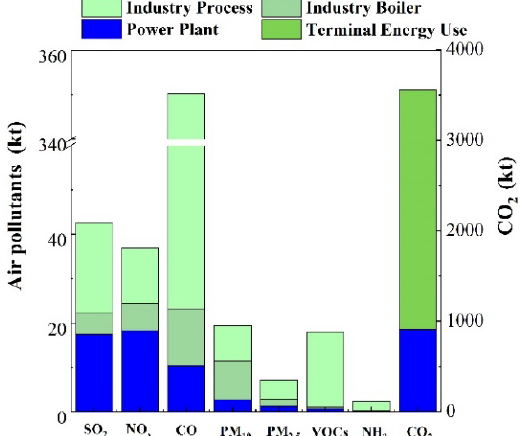
Figure 3. Emissions of air pollutants and CO 2 in industrial parks and sector contribution rates in 2017 (Note: For CO 2 , Industry Process and Industry Boiler are collectively called Terminal Energy Use).